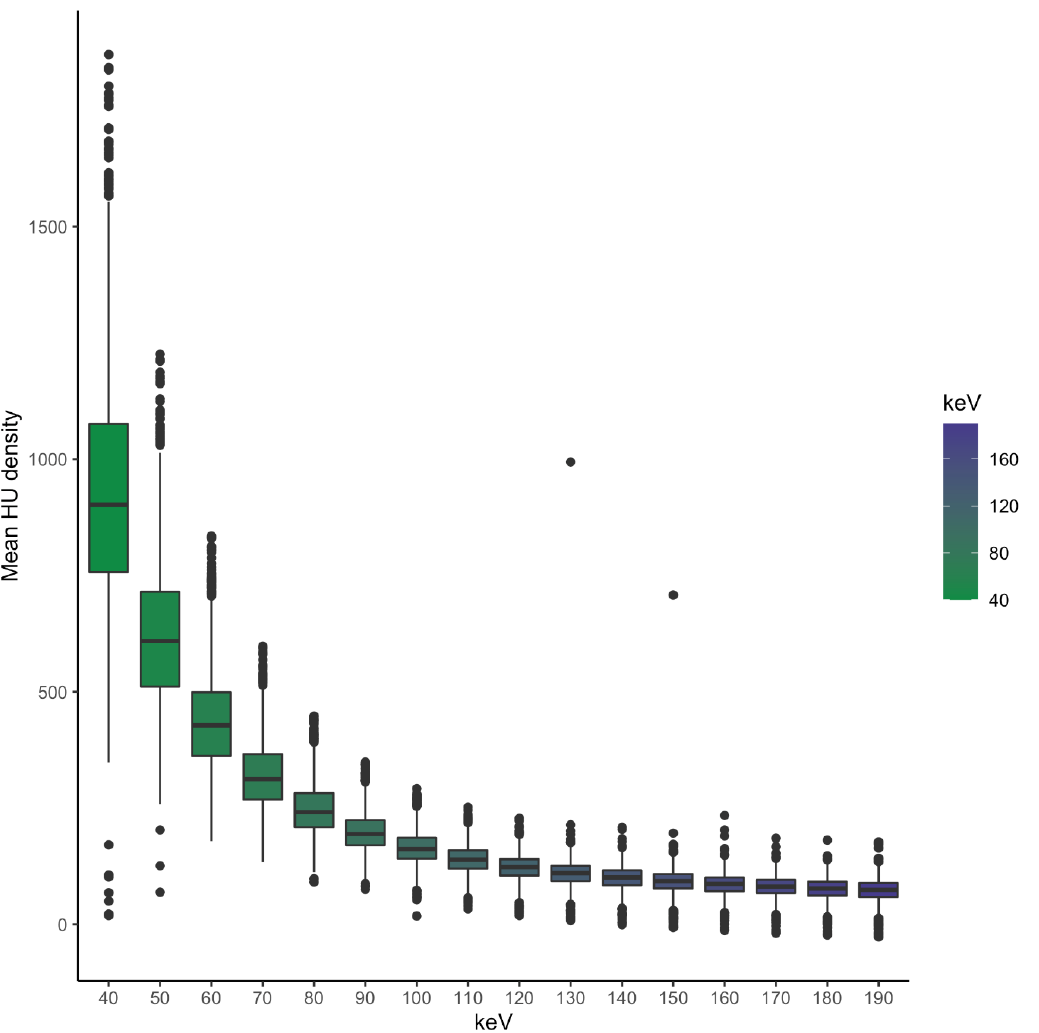
Figure 2. Decreasing mean vessel attenuation of all examined vessels with increasing virtual mo- noenergetic energy threshold levels.